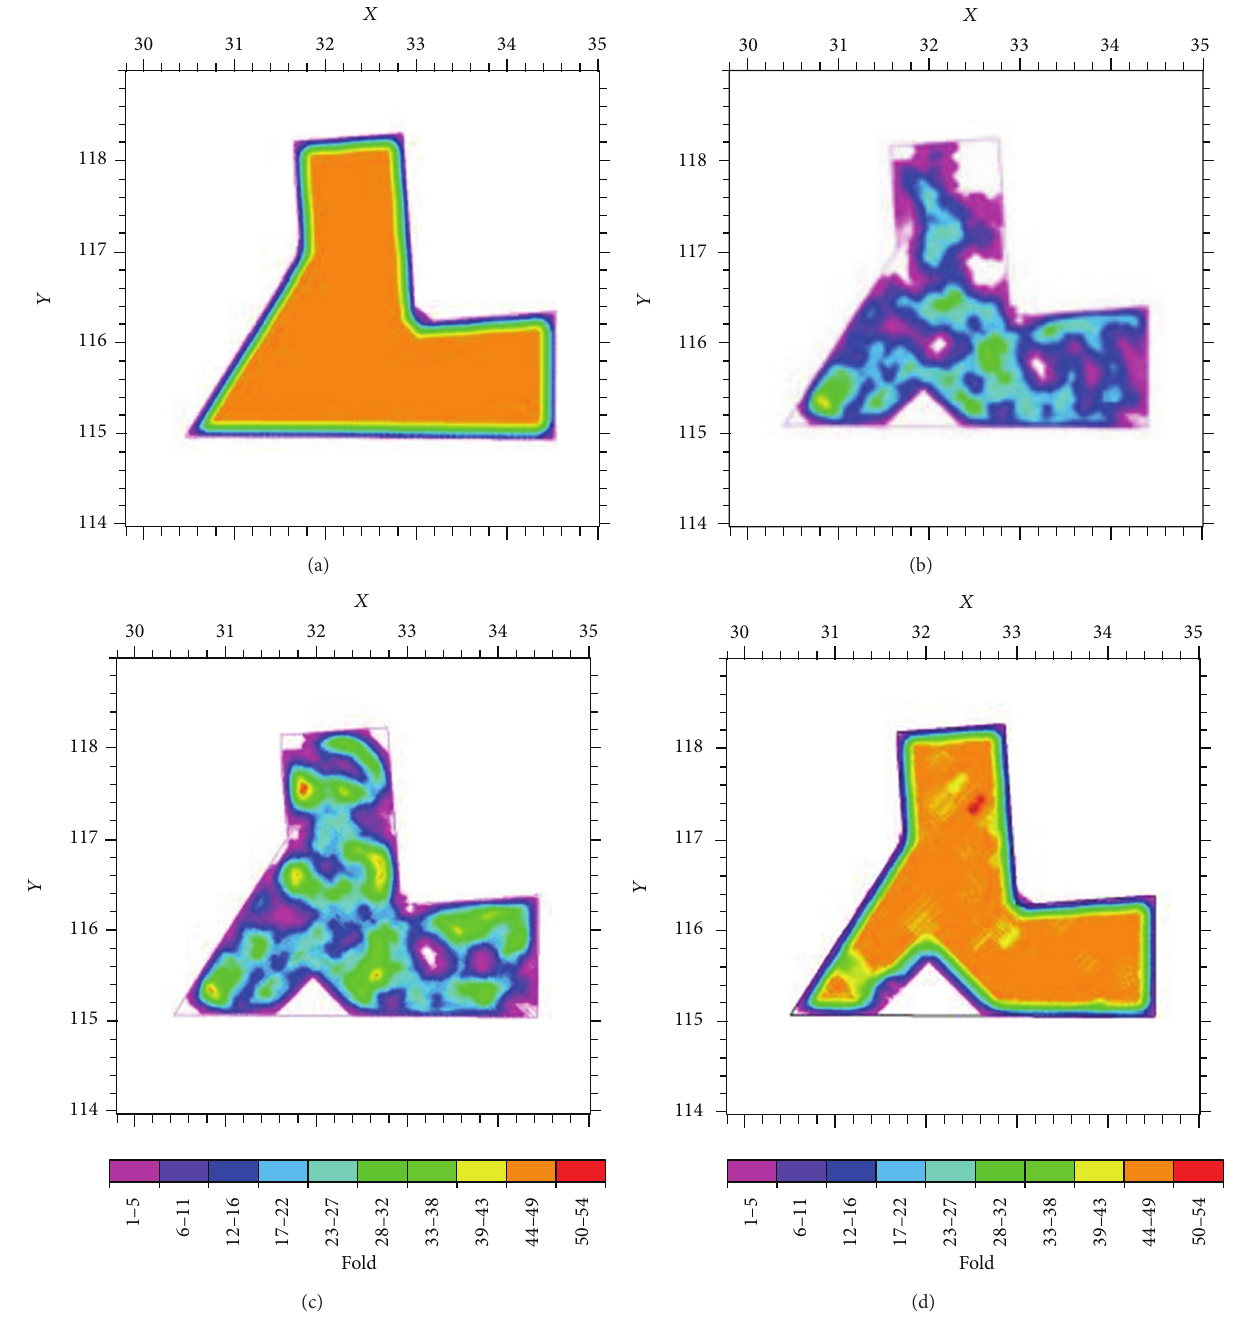
Figure 8: Total fold map in (a) acquisition with no cultural noise, (b) acquisition with real cultural noise, (c) traditional recovery method applied on (b), and (d) new recovery strategies applied on